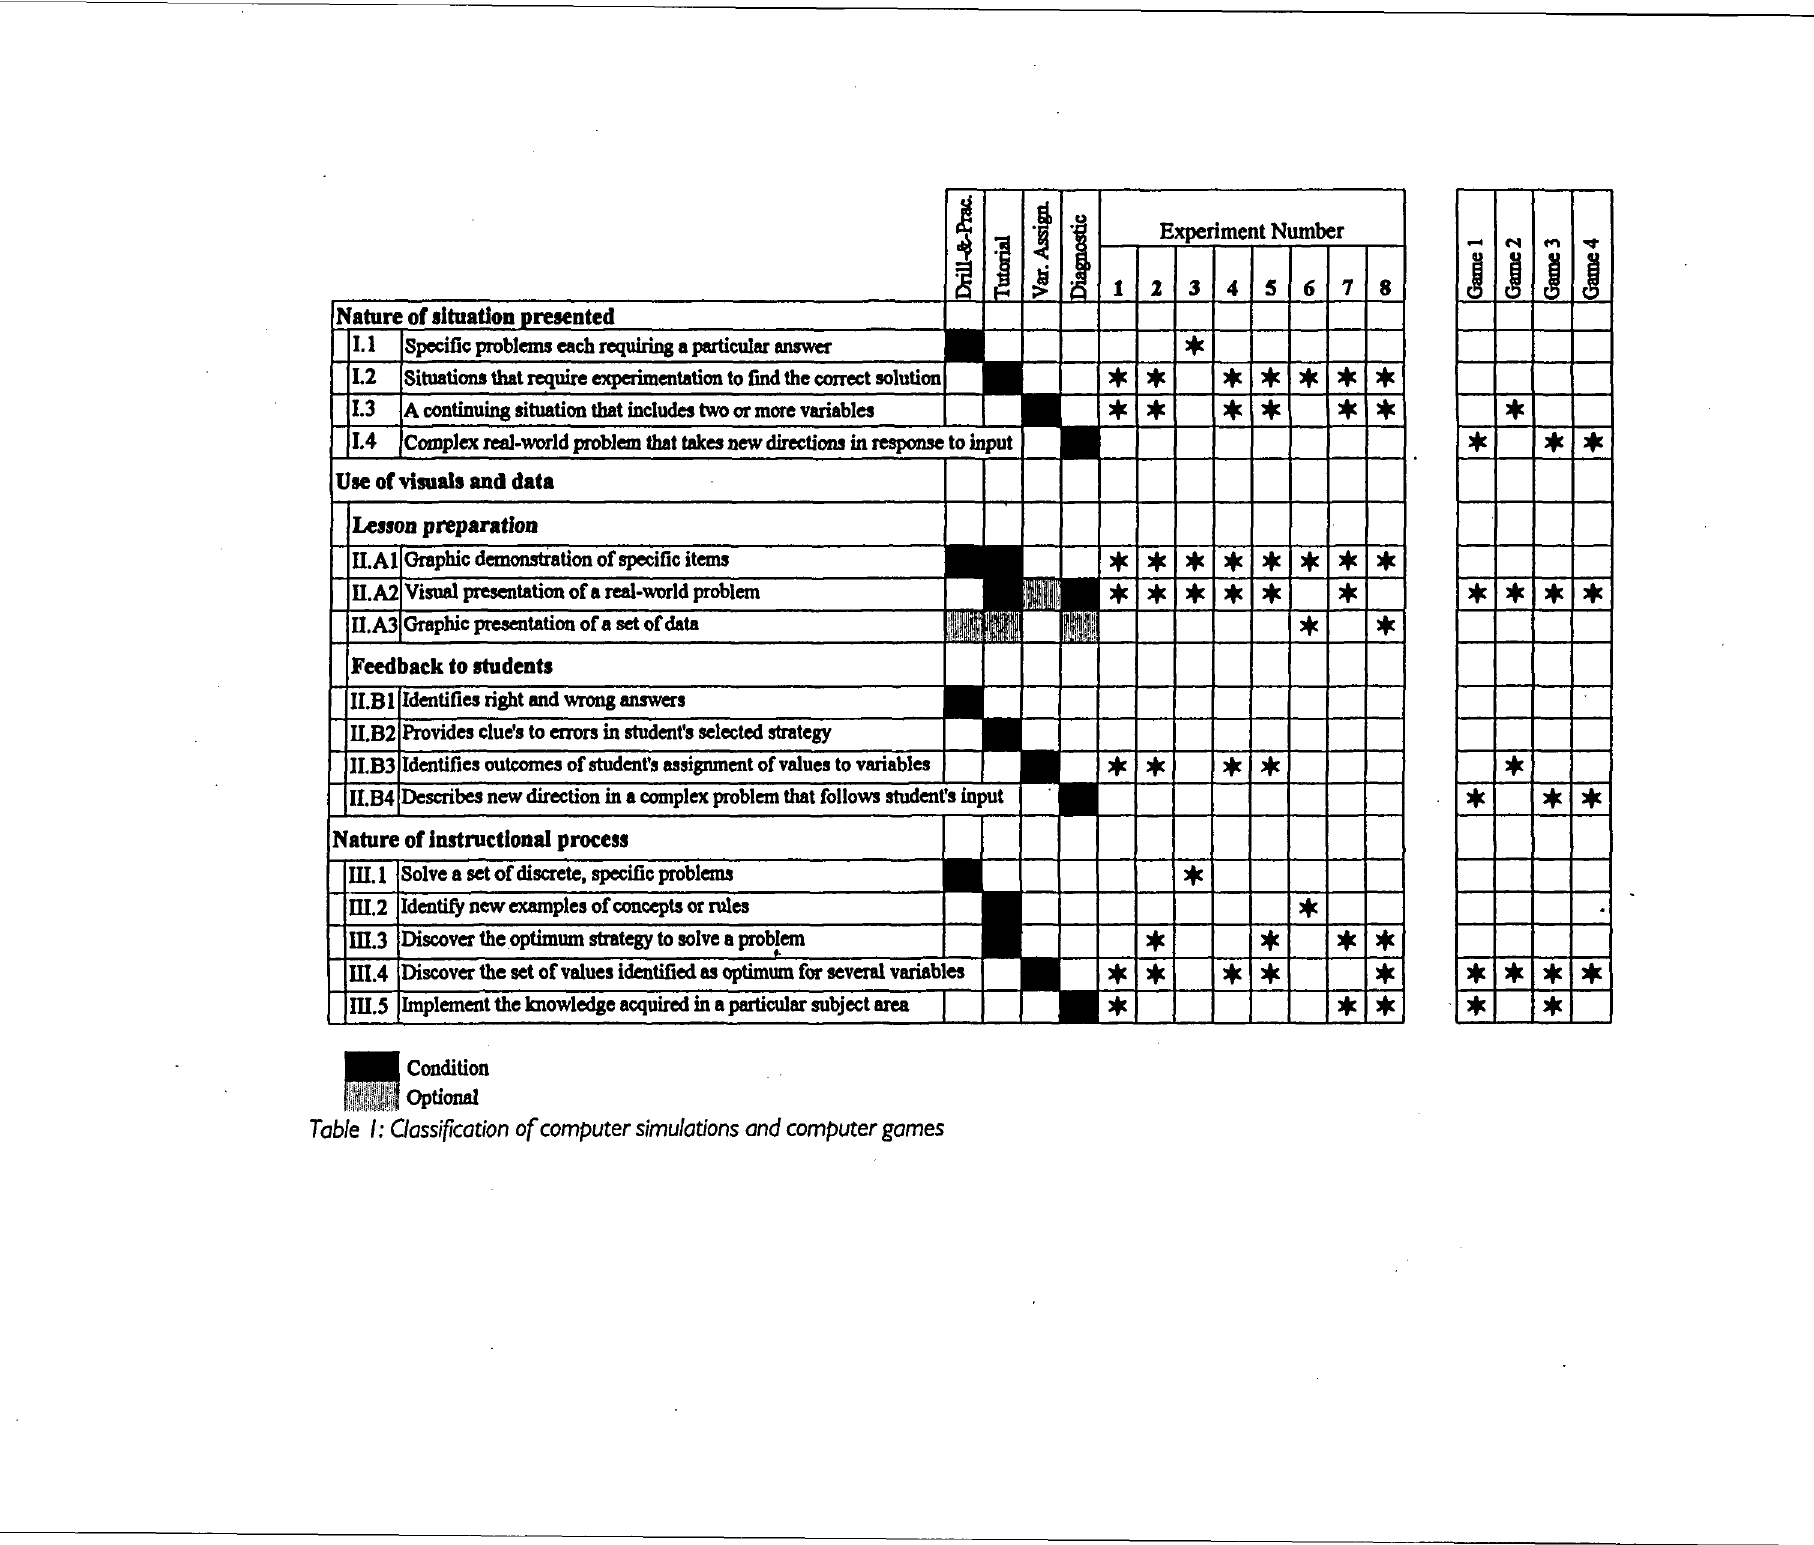
Table I: Classification of computer simulations and computer